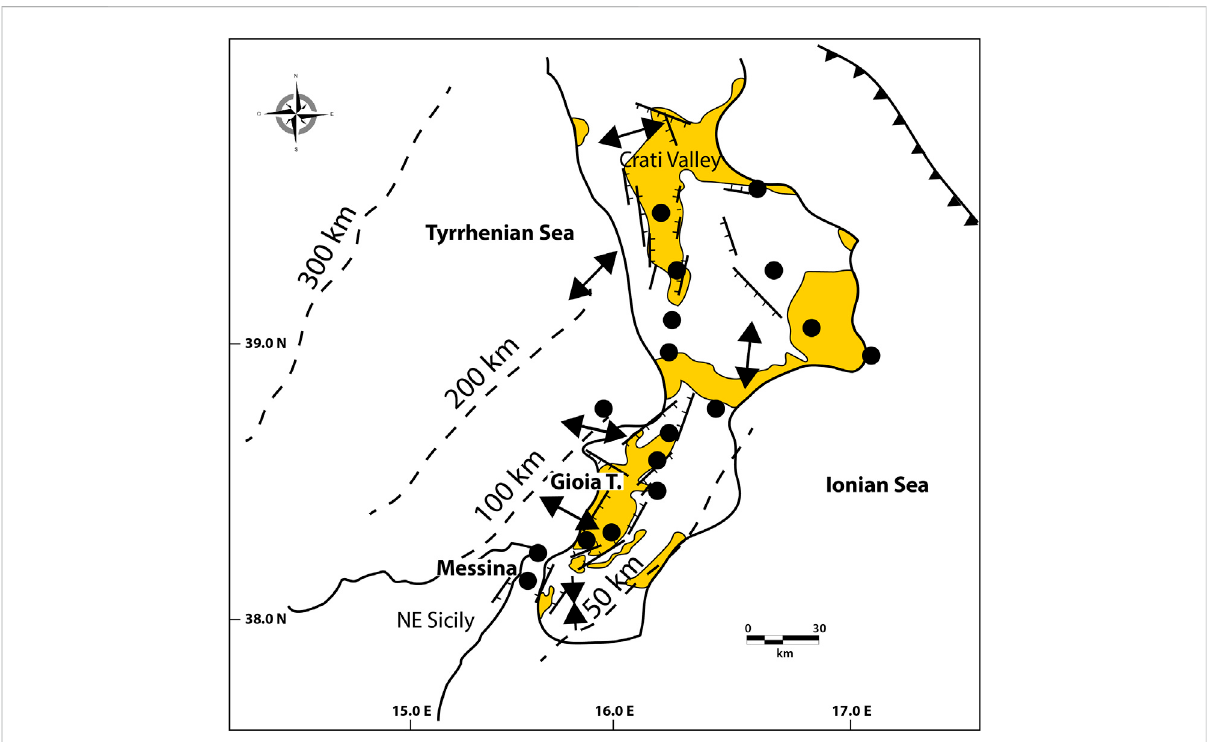
FIGURE 2 Structural and kinematic sketch of the Calabrian Arc. Horizontal strain-rate modi fi ed after Faccenna et al. (2014) (Converging black arrows, compressionalmeanrate;divergingblackarrows,extensionalmeanrate).Solidblacklinewithtrianglesindicatesthepresent-daywedgefrontofthe Arc. Quaternary continental and marine deposits are shown in yellow. Black circles indicate the epicenters of M > 6 earthquakes from the Catalogo Parametrico dei Terremoti Italiani (Rovida et al., 2021). Solid lines indicate the main faults from DISS Working Group (2021) and from ITHACA Working group (2019); barbs indicate the downthrown side. Dashed lines show the isobaths of the top of the Ionian slab from Galli and Peronace